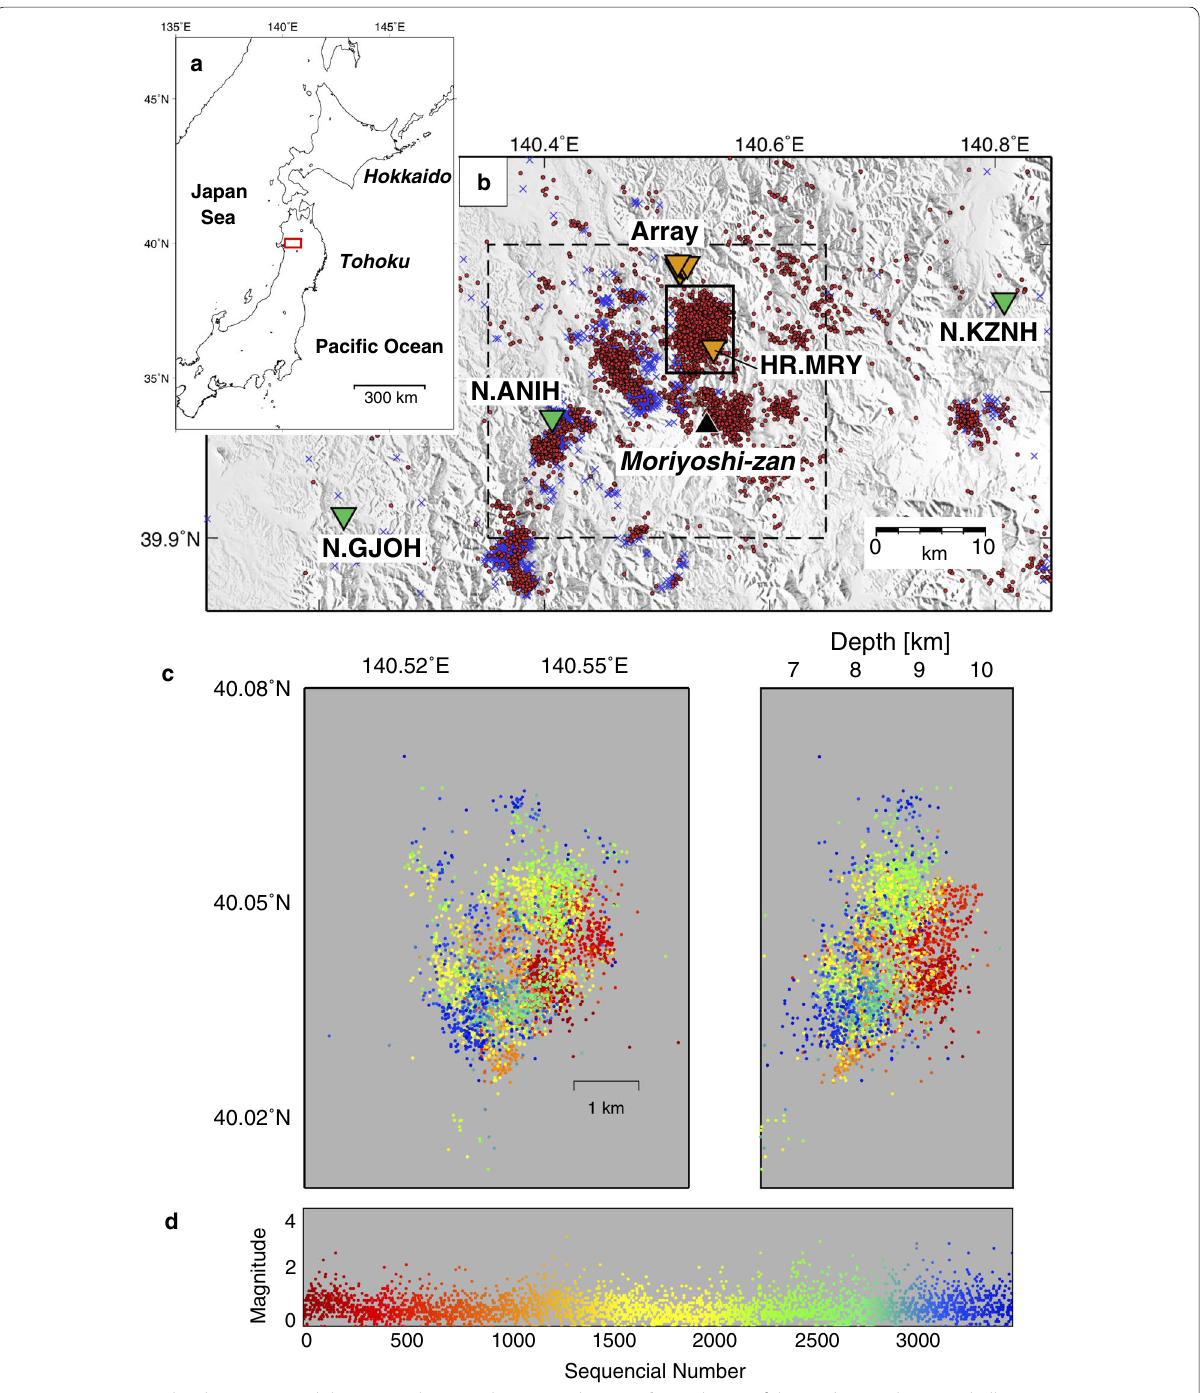
Fig. 1 Hypocenter distribution around the Moriyoshi-zan volcano. a Index map. b Areal map of the study area showing shallow seismicity ( 15 km) before and after the Tohoku earthquake (blue crosses: January 2006–March 2011; red circles: March 2011–November 2016) from the ≤ unified catalog of the Japan Meteorological Agency (JMA). The solid rectangle represents the largest cluster in which hypocenter migration was observed. The broken rectangle represents the area shown in Figs. 2, 8, and 9. Green and orange inverted triangles denote Hi-net and temporary seismic stations, respectively. c Relocated hypocenter distribution in the largest cluster in b . Color of the circles shows the chronological sequential number of earthquakes in the period from March 2011 to November 2016. d Magnitude versus sequential number